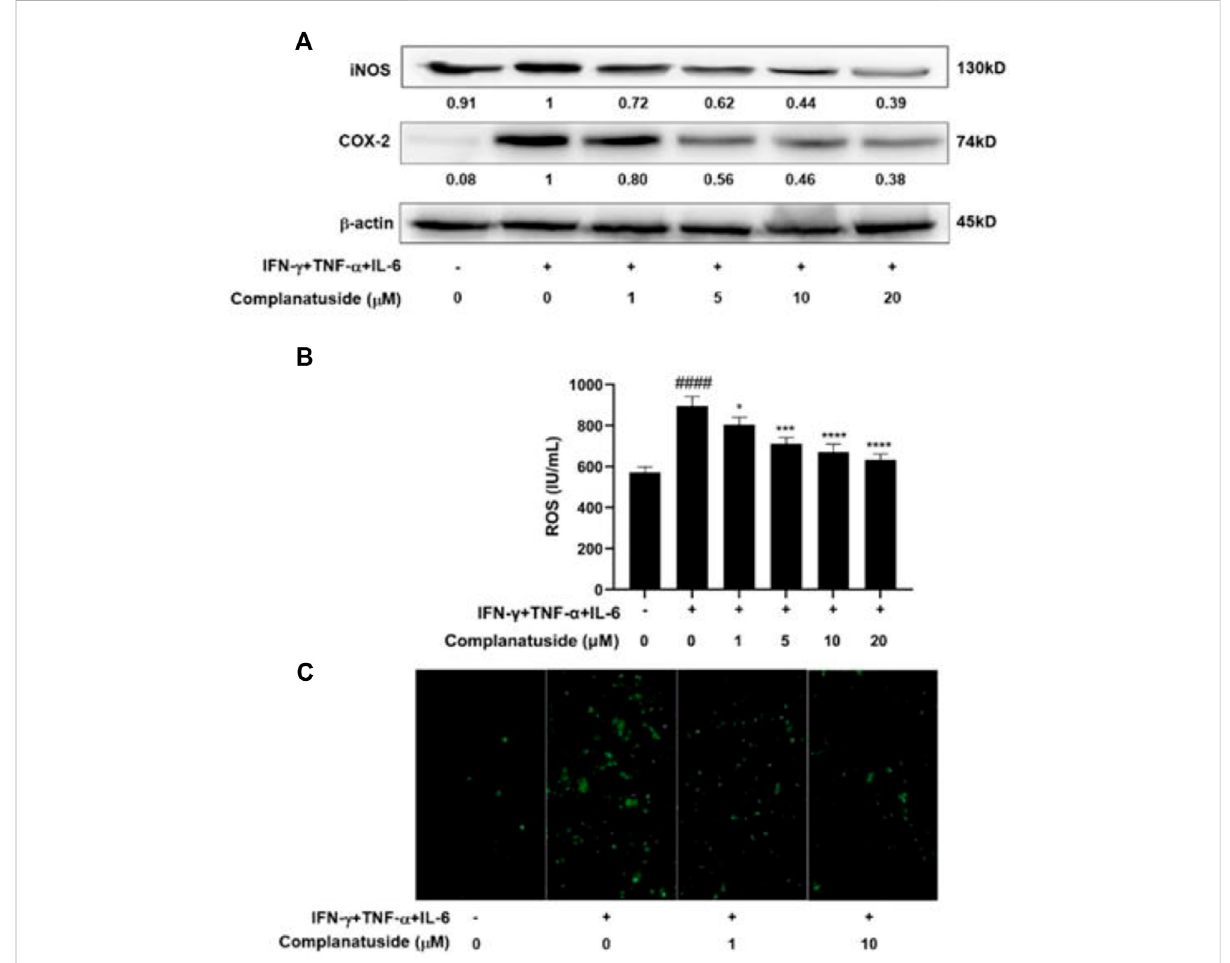
FIGURE 7 Effects of complanatuside on the levels of iNOS, COX-2, and ROS in HaCaT cells treated with the cytokine combination. HaCaT cells were treated with various concentrations of complanatuside with or without co-treatment with the cytokine combination for 24 h. (A) The levels of iNOS and COX-2 were determined by Western blot analysis. (B) ROS was detected using the fl uorescence dye DCFH-DA and ELISA. ROS levels in HaCaTcellstreatedwithcomplanatusidewithorwithoutco-treatmentwiththecytokinecombination.Thedatawerepresentedasmean±SD. Asterisk indicates comparison between the cytokine combination-treated group and complanatuside-treated groups ( * = p < 0.05, ** * = p < 0.001, and **** = p < 0.0001). The number sign # indicates comparison between thecells treated with cytokinecombination and the cells in control group ( #### = p < 0.0001). (C) Representative micrographs of ROS fl uorescence staining of HaCaT cells treated with complanatuside in the presence or absence of the cytokine combination (Size bar = 50